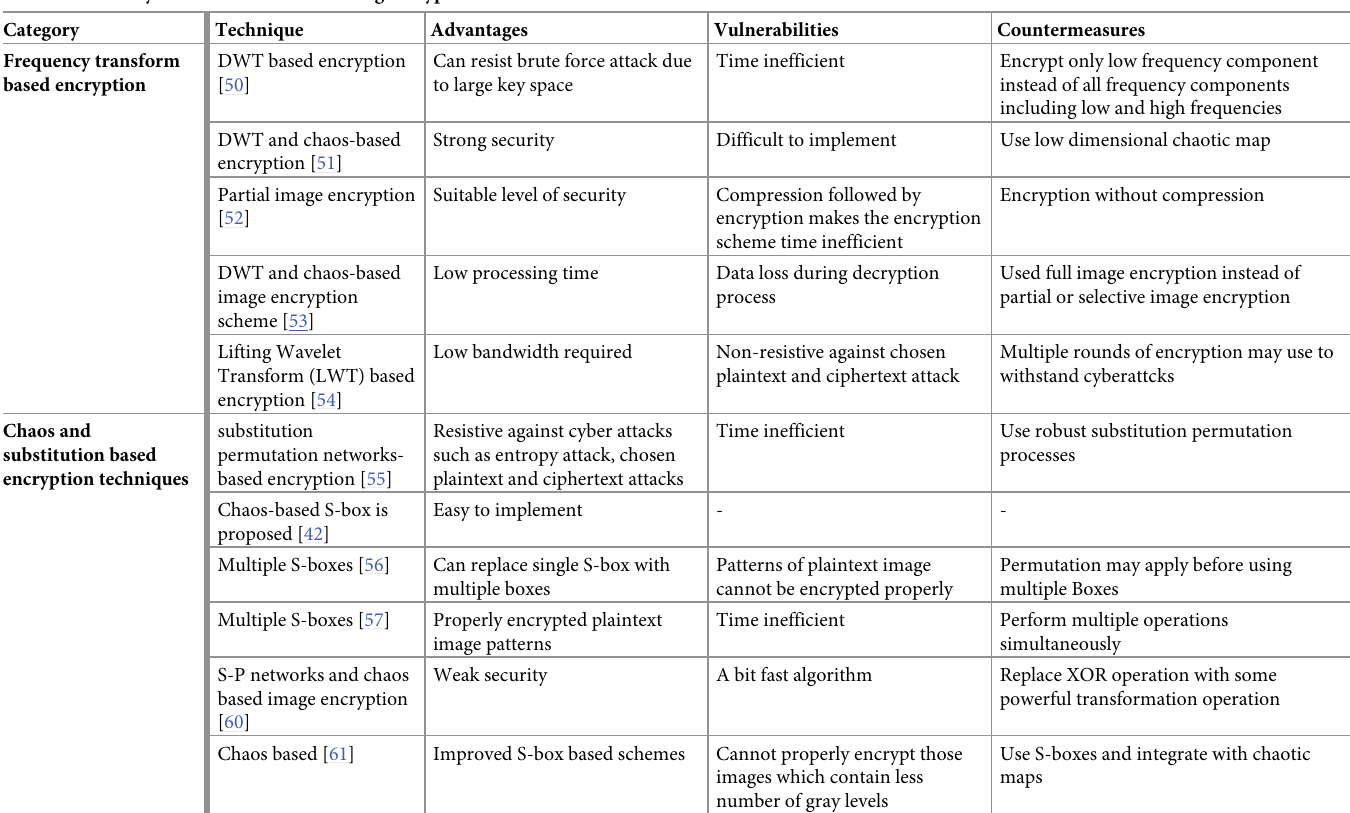
Table 1. Summary of transform based existing encryption